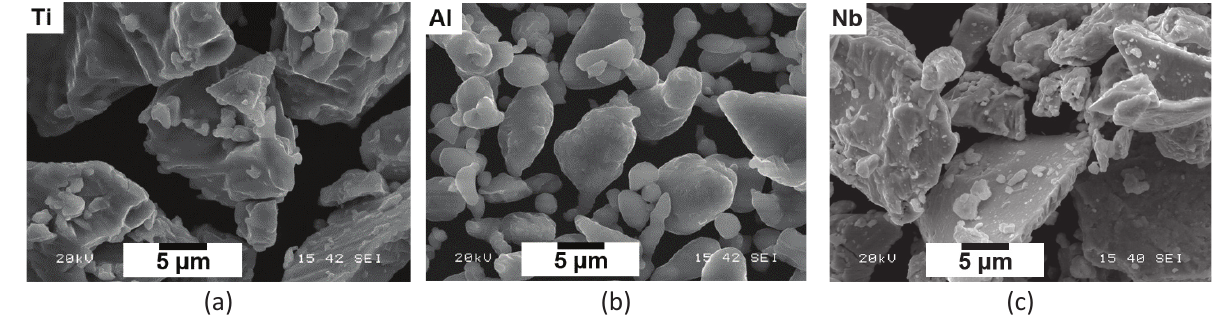
Figure 3: SEM Migrographs of (a) Ti, (b) Al, (c)Nb